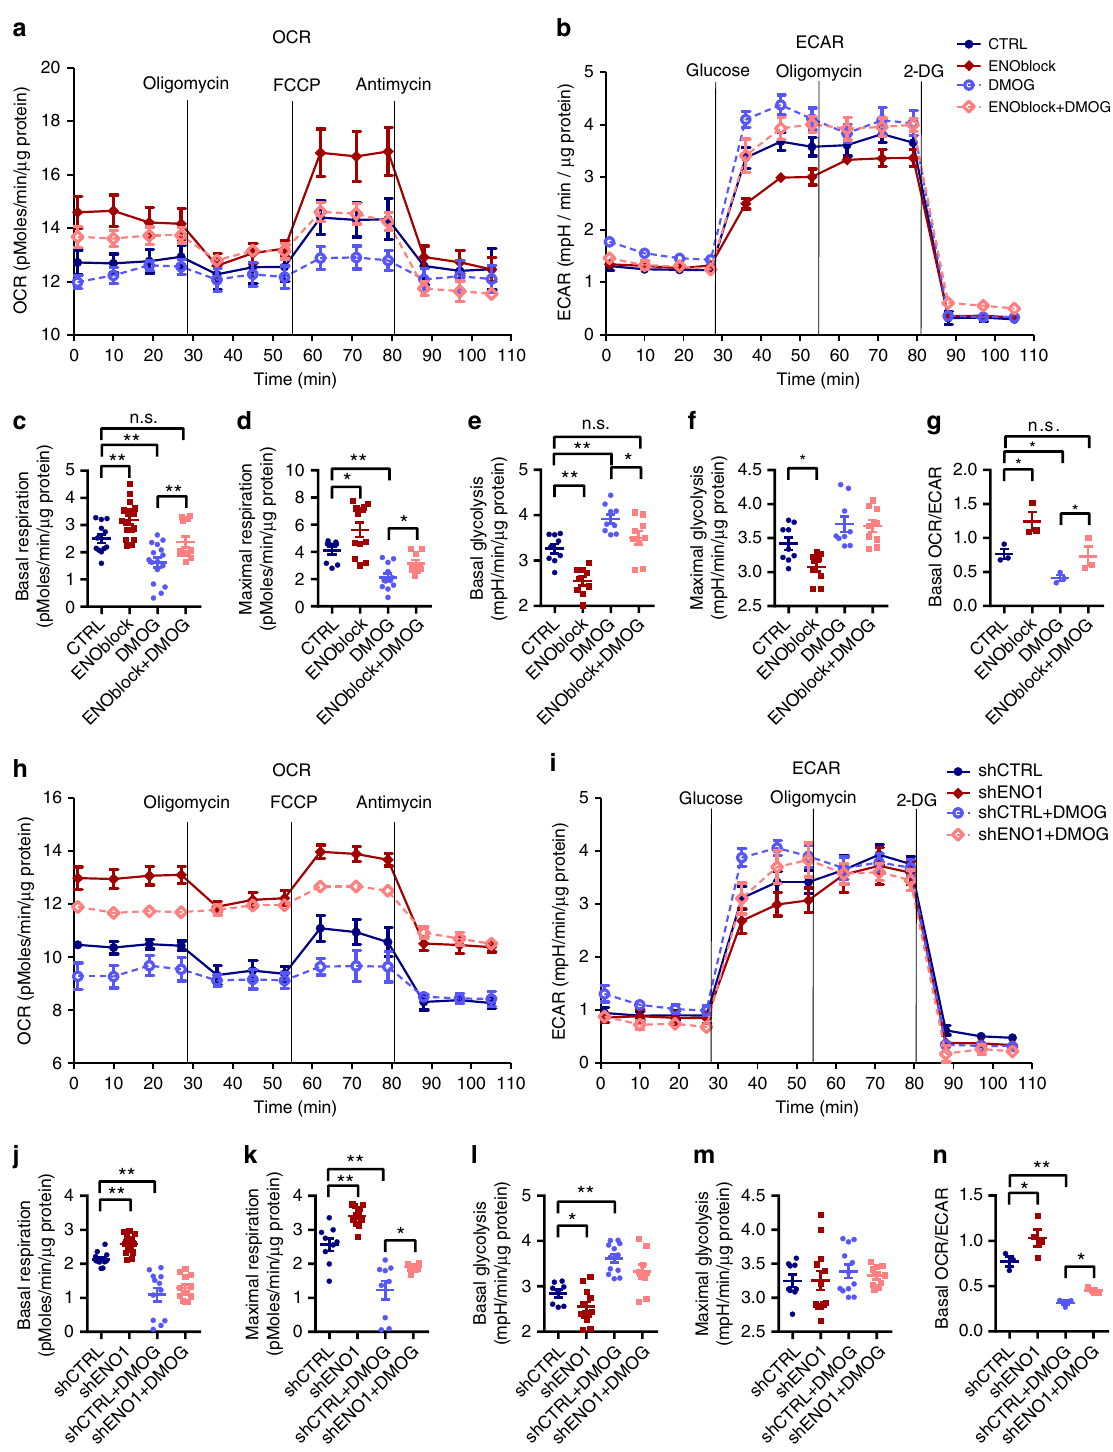
Fig. 6 Suppression of ENO1 prevents DMOG-mediated metabolic shift in PASMC. a Normal PASMCs were treated with 10 μ M ENOblock for 12 h before the Seahorse assay. The OCR levels were measured using the mitochondrial stress test ( n = 3 – 4 per group), and b the ECAR levels were measured using the glycolysis stress test in ENOblock-treated PASMCs ( n = 3 per group). DMOG was used to mimic hypoxic conditions. The basal c and maximal d respiration level, basal e , and maximal f glycolytic level, and basal OCR/ECAR g were calculated accordingly. h The OCR levels were measured using the mitochondrial stress test ( n = 3 – 4 per group) and the ECAR levels were measured using the glycolysis stress test in shENO1 – PASMC ( n = 3 – 4 per group). The basal j and maximal k respiration level, basal l , and maximal m glycolytic level, and basal OCR/ECAR n were calculated. * P < 0.05, ** P < 0.01, n.s. = non-signi fi cance. Data represent the mean ± SEM. Student t test and one-way ANOVA were used to compare two and multiple groups. Bonferroni post- tests were carried out after